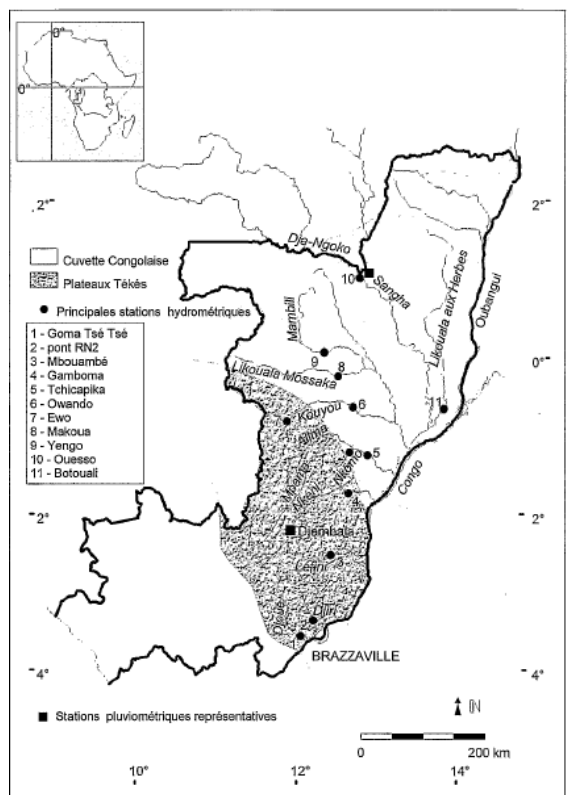
Figure 17. Congolese tributaries of the Congo River and smoothed contours of the Batéké plateau and of the “Cuvette Centrale’ on the right bank of the Congo River [10]”. Legend: ‘Plateaux Tékés’ = Batéké plateau’; ‘Principales stations hydrométriques’ = Main gauging stations; ‘Stations pluviométriques représentatives’ = Representative rainfall stations.